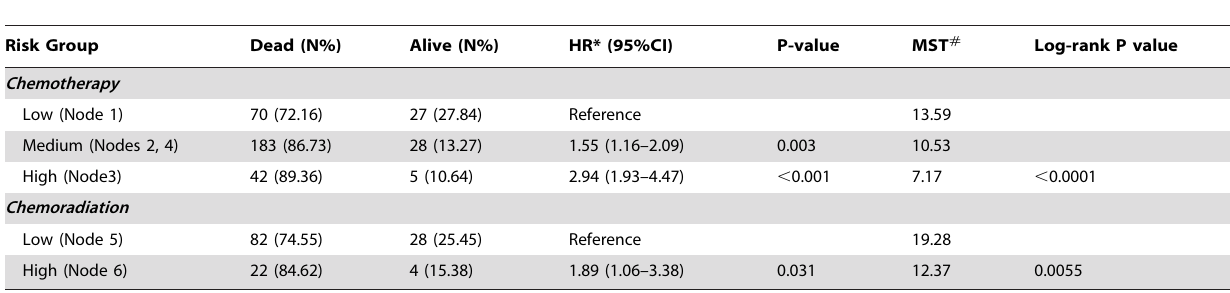
Table 6. Cox proportional hazards regression model in late-stage NSCLC patients based on the Survival tree